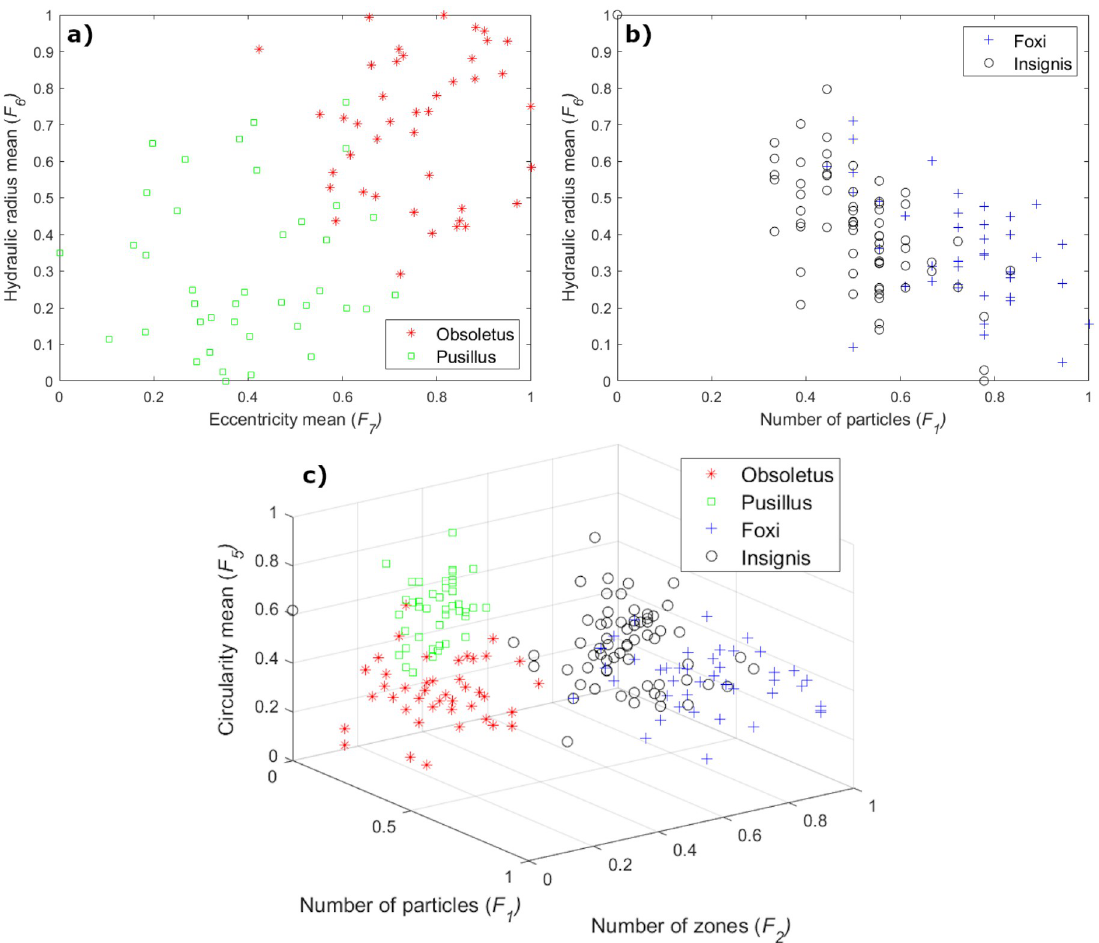
Fig 9. Biting midges species separation according to the optimal subset of features in (a) fDataset, (b) eDataset, and (c) both datasets together.